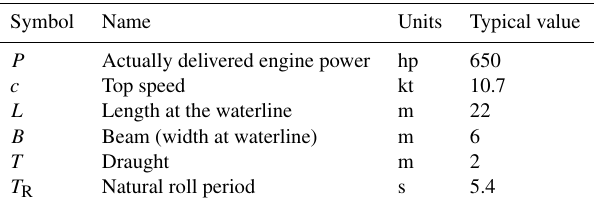
Table 1. Parameters of the motorboat model and their values for the case study of Fig.